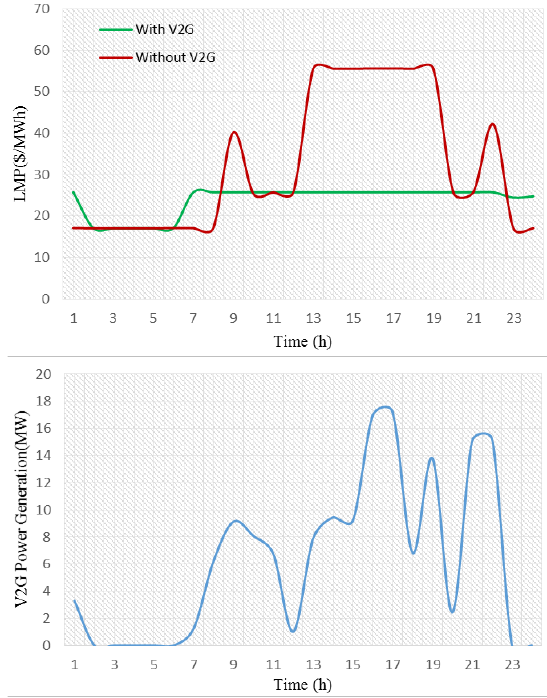
Figure 8. LMP curve of bus 4 for both cases — with and without V2G.